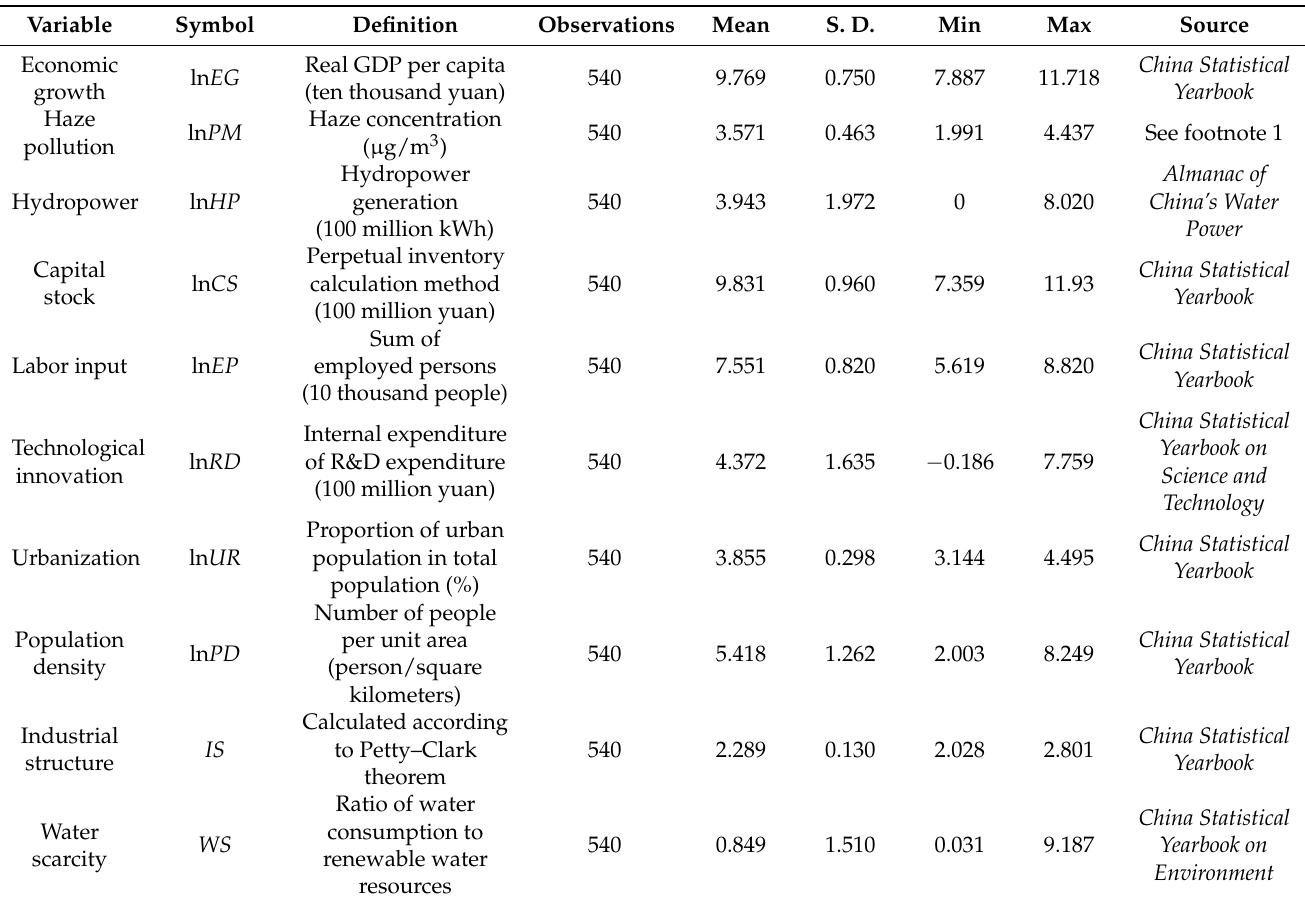
Table 1. Descriptive statistics of